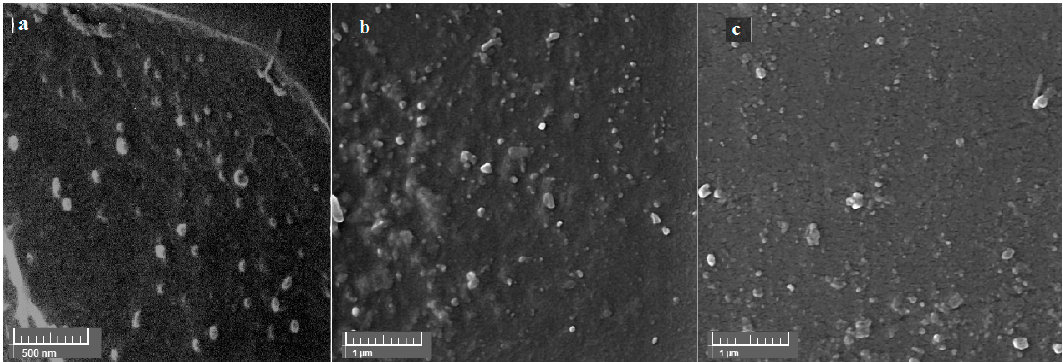
Figure 6. SEM images of ( a ) Eudragit ® L100 nanoparticles, ( b ) AZM film-HPMC, and ( c ) AZM film- Figure6. SEMimagesof( a )Eudragit ® L100nanoparticles, ( b )AZMfilm-HPMC,and( c HEC.